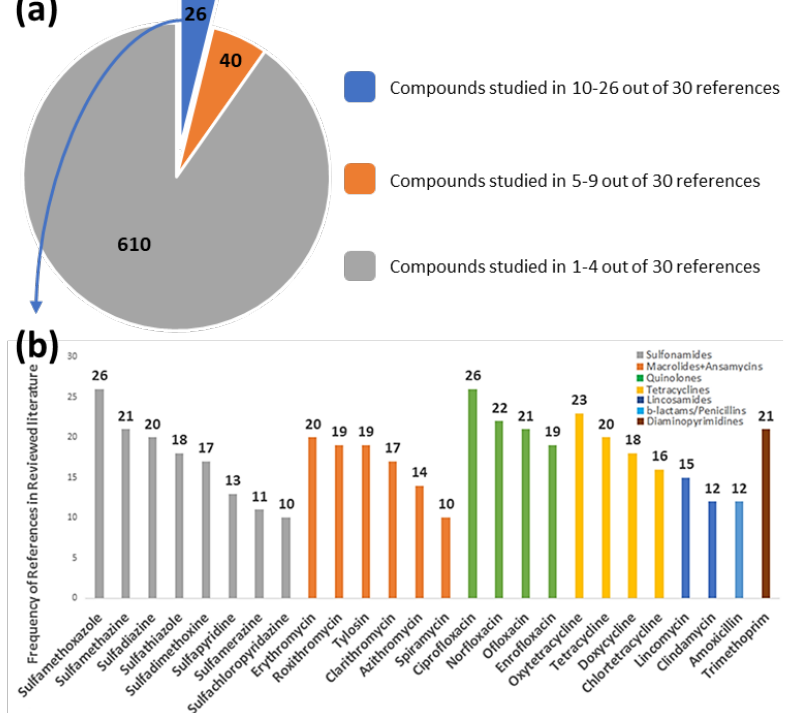
Figure 1. ( a ) Pie chart representing the availability of occurrence profile of the 676 studied antibiotics from the 30 references in the literature review; ( b ) bar chart showing frequency of references (and chemical classes by colour) for the 26 most studied antibiotics (blue shaded in the pie chart).